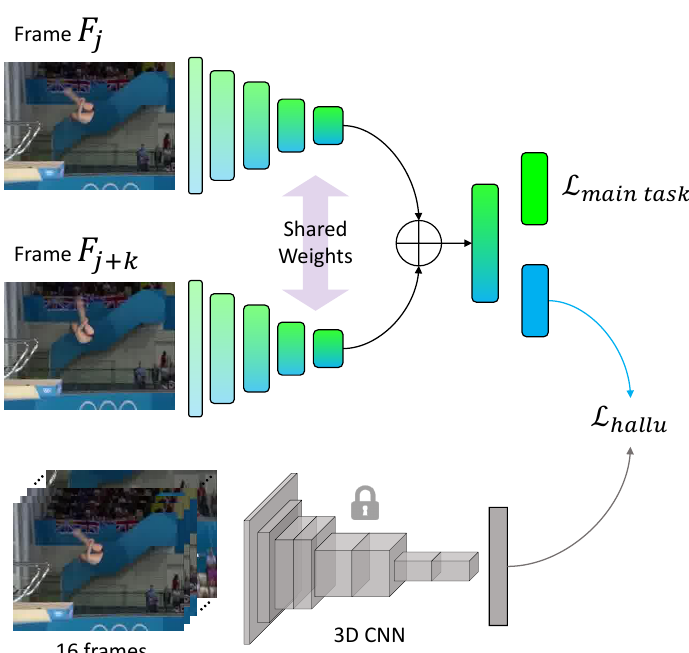
Figure 4. Multiframe architecture. Instead of using a single frame to hallucinate, representations of ordered frames are concatenated ( ⊕ ), which is then used for hallucinating. Everything else remains the same as our single frame